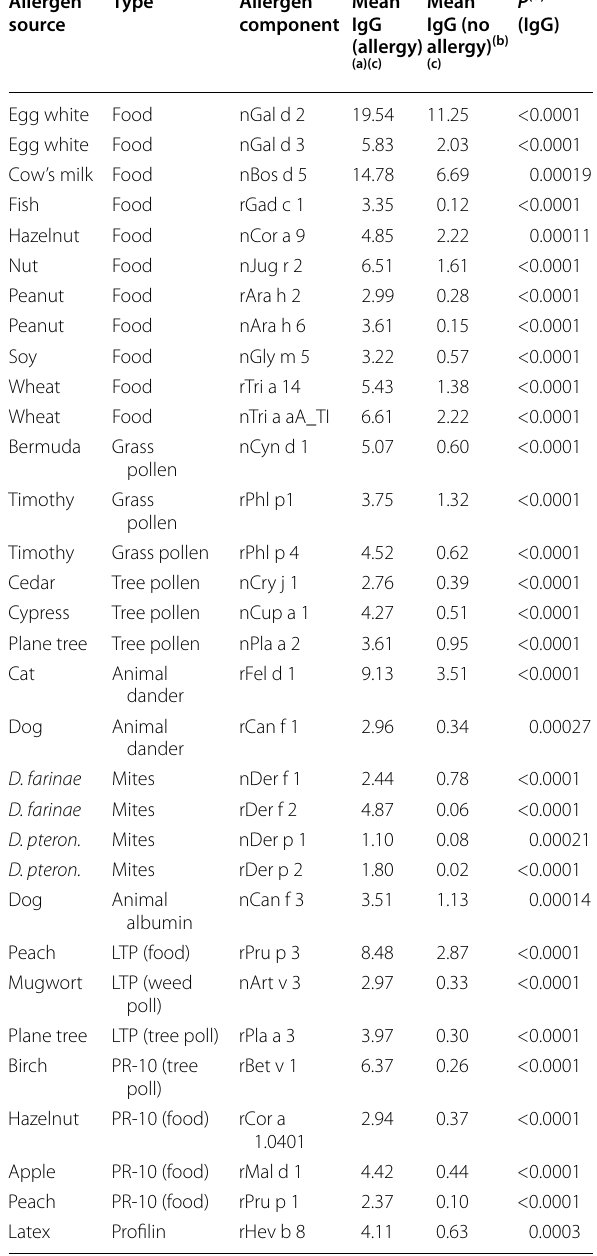
Conclusions : Our results demonstrate that, in allergic patients, IgG sensitization is mostly directed against the same targets as that of IgE sensitization. This implies that, out of the context of SIT, IgG are most probably not able to protect allergic patients from IgE-mediated symptoms. In addition, we found that at least for some allergens (e.g. pollens from hazelnut, timothy-grass and olive tree), the selection of the immunoglobulin isotype during anti-allergen humoral responses is dependent on the allergen molecule itself (Table 2). Table 2 Compared to non‑allergic individuals, aller‑ gic patients have higher concentrations of specific